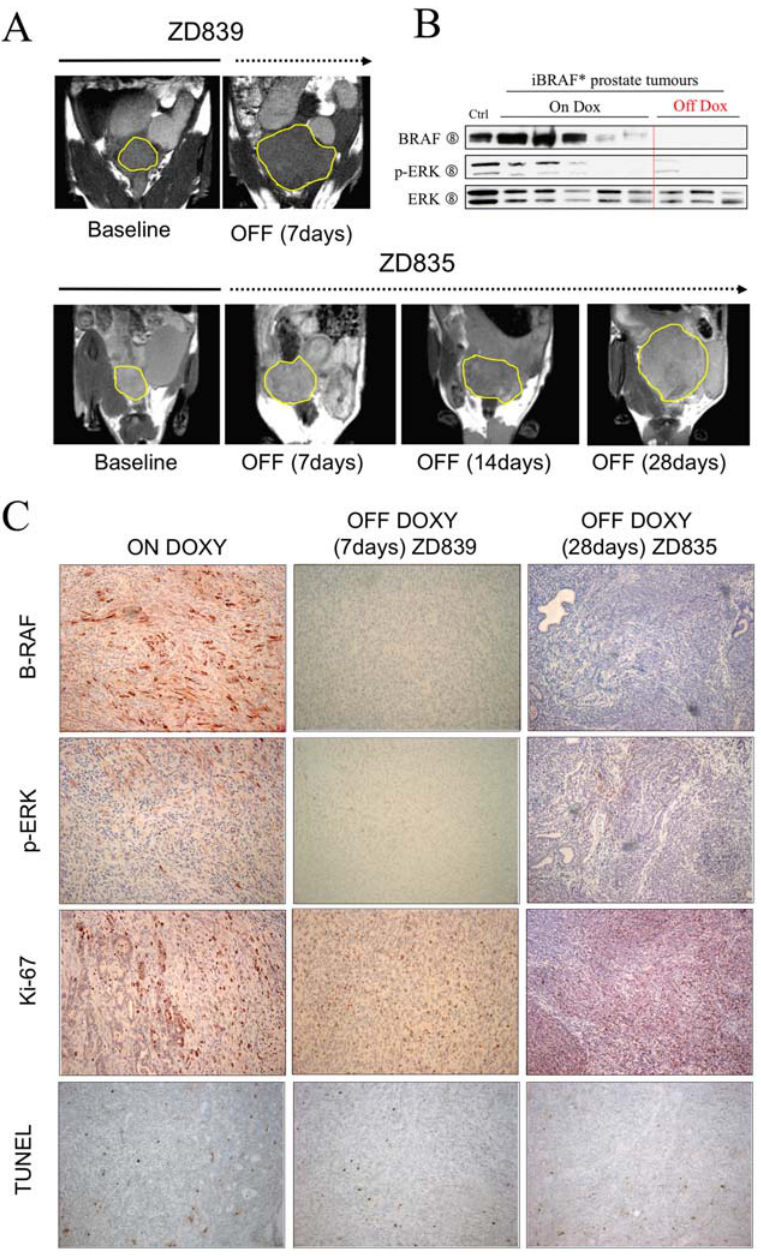
Figure 7. iBRAF* prostate tumors do not require BRAF activation for their tumor maintenance. A. Tumor size change was monitored by serial MRI imaging before (baseline; solid line) and after (indicated periods; dotted line) doxycycline withdrawal (7 days for ZD839 and 28 days for ZD835). Yellow line indicates tumor boundary. B. B-RAF expression and p-ERK activation were not detected by immunoblotting analysis in most of off doxycycline iBRAF* PCA tumors (n=3), although one of the off doxycycline iBRAF* tumor samples (ZD835) showed weak p-ERK activation. C. Immunohistological examination using antibodies against B-RAF and p-ERK confirmed the repression of B-RAF* transgene repression during off doxycycline periods (7 days for ZD839 and 28 days for ZD835). However, the tumors were viable and still growing, as manifested by low apoptosis on TUNEL and active proliferation by Ki67 staining.